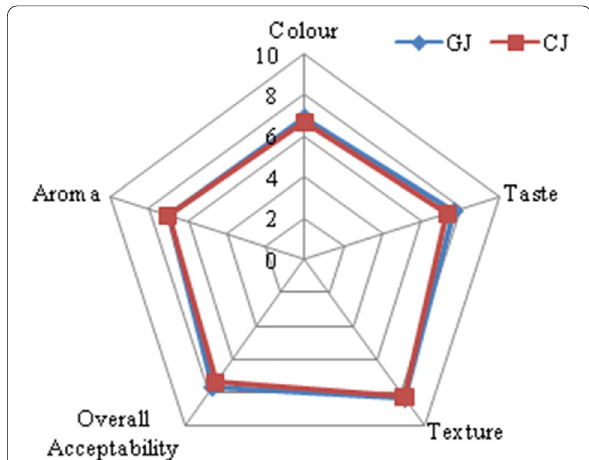
Fig. 3 Sensory evaluations of control and guava leaf extract